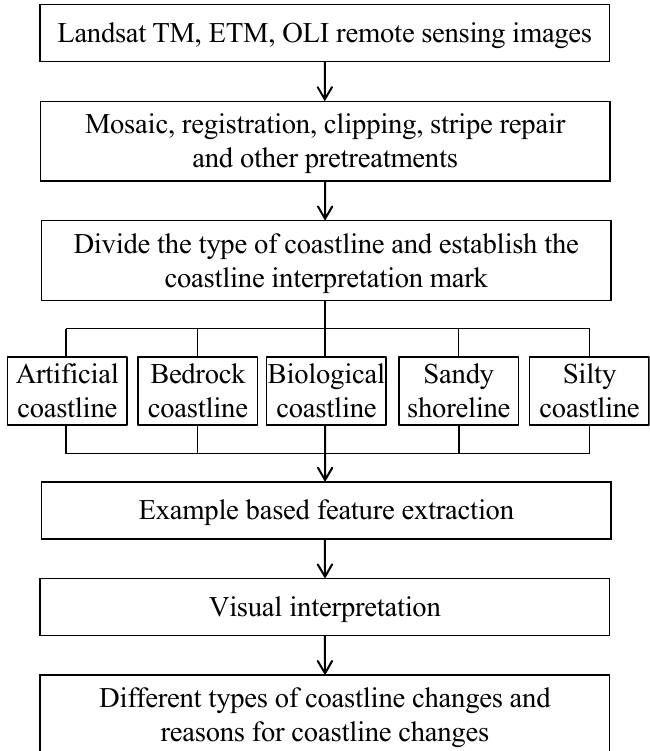
Figure 3. Technology route of coastline extraction.